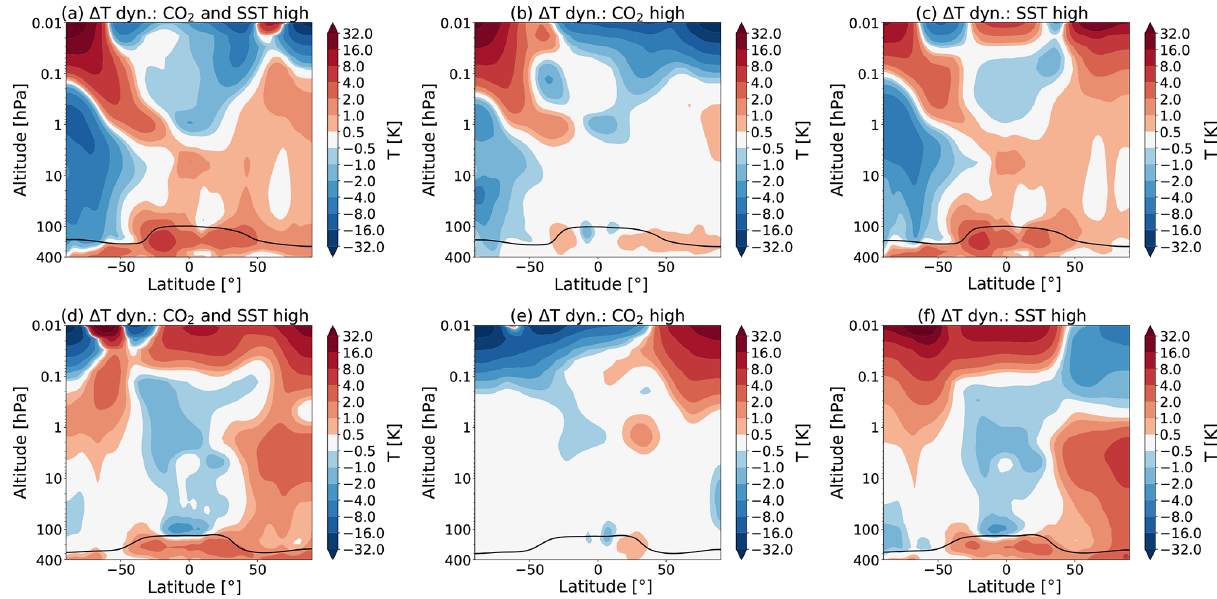
Figure 7. Partial temperature responses to changes in dynamics, as calculated by CFRAM, in July (a–c) and January (d–f) due to (a, d) the combined effect of the CO 2 increase and SST changes (experiment S3), (b, e) the doubling of the atmospheric CO 2 concentration (experiment S1) and the (c, f) SSTs (experiment S2). The tropopause height is indicated as in Fig. 1.